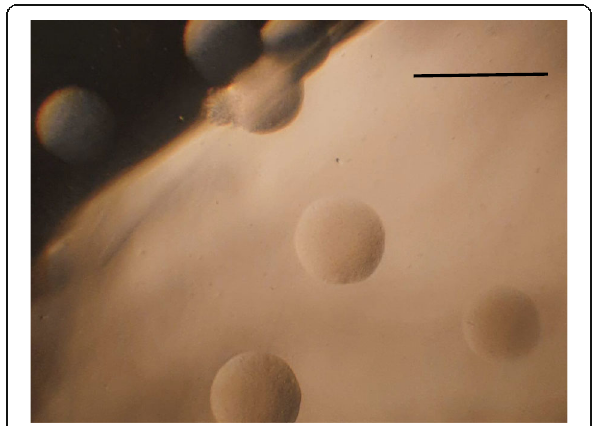
Fig. 1 Colonies of Mycoplasma capricolum subsp. Capricolum on PPLO agar with a characteristic fried egg appearance. bar means1